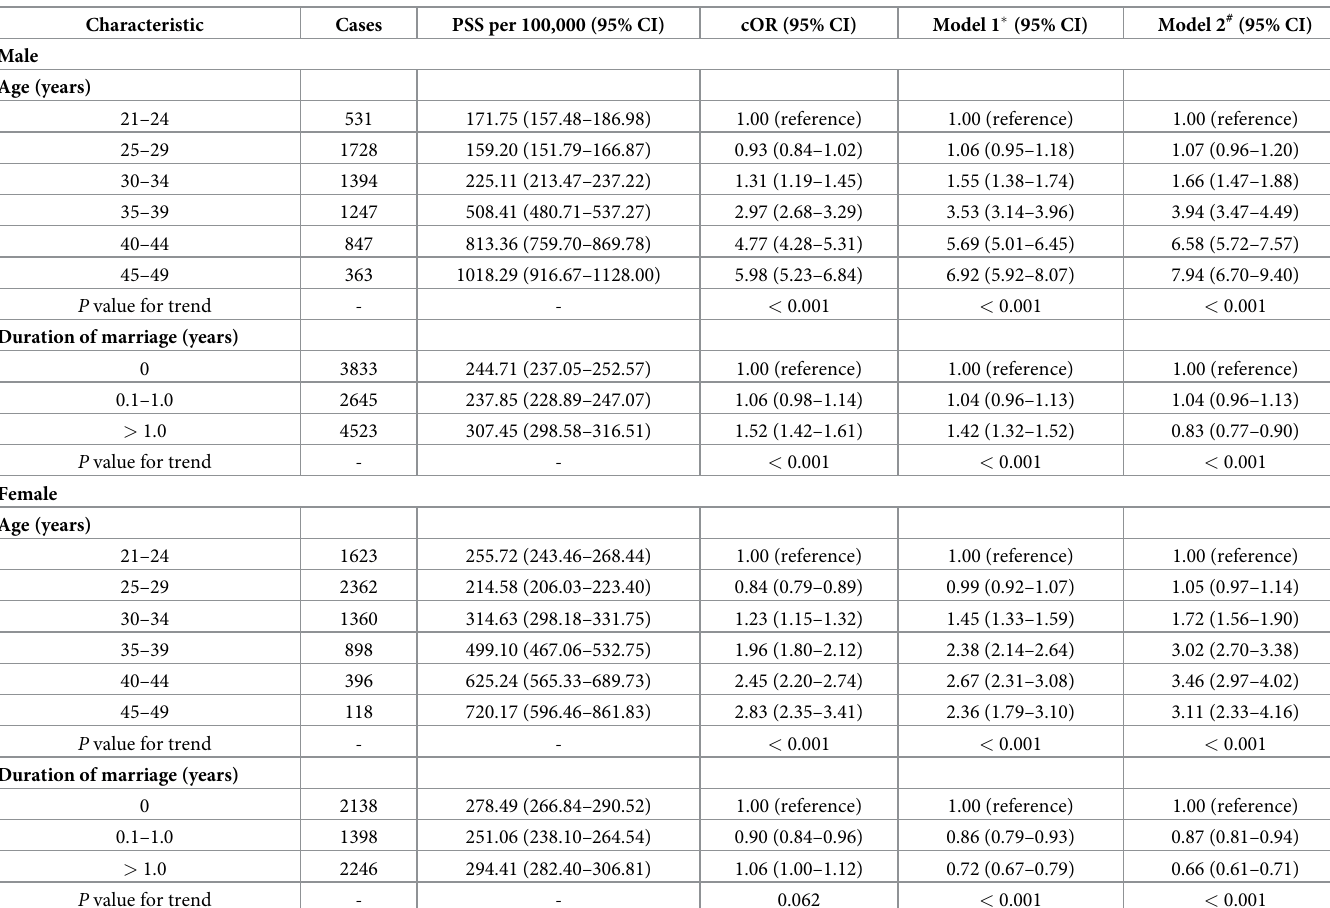
Table 2. Odds ratio (95% CI) of PSS according to duration of marriage and age among married individuals aged 21–49 in Guangdong Province, 2014–2019.